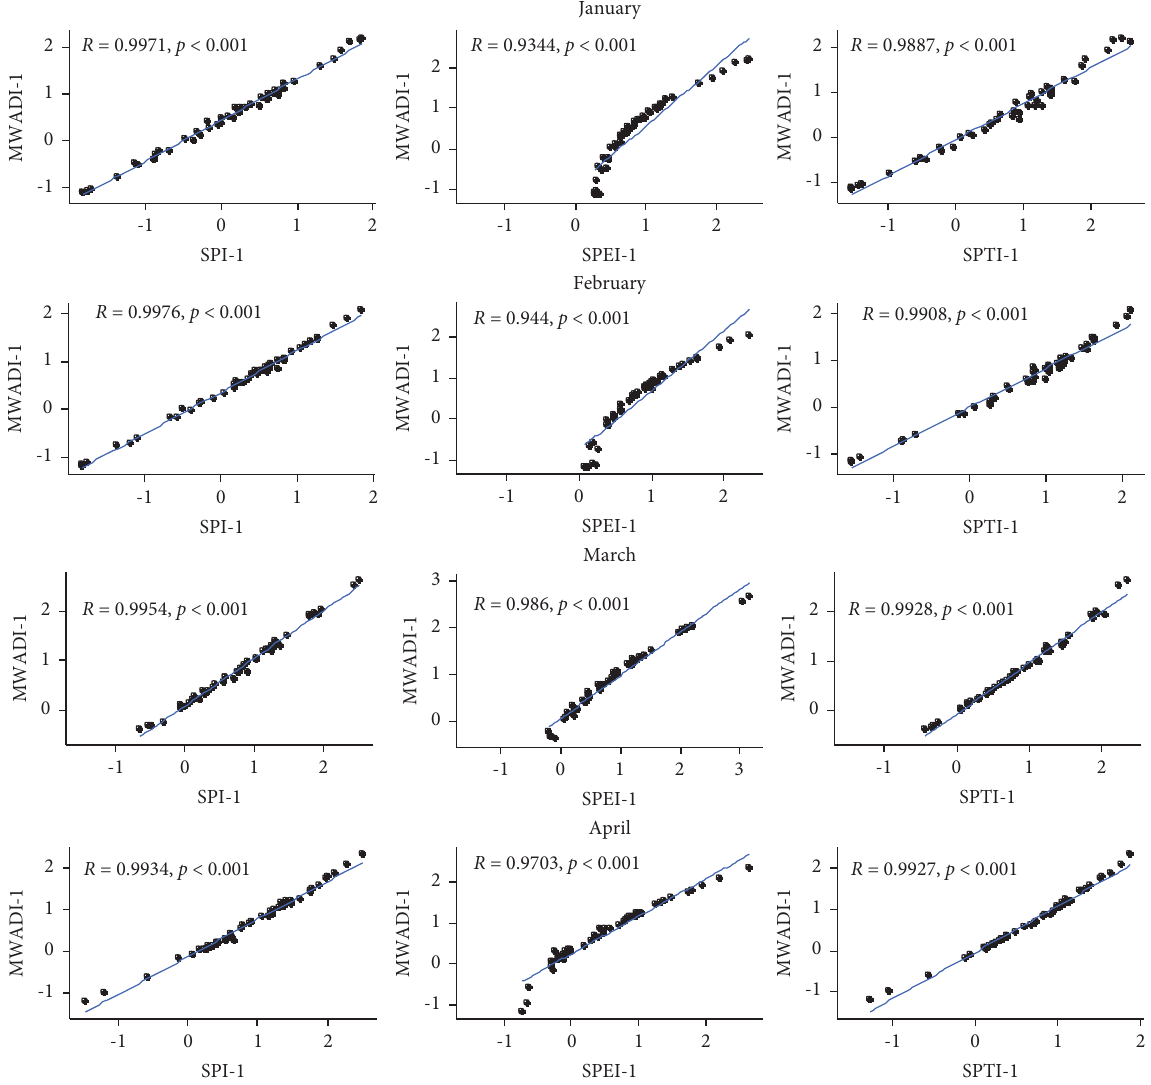
Figure 4: Te scatter diagram and correlation coefcient R values between the seasonal MWADI and the SPI, the SPEI, and the SPTI (January–April) at